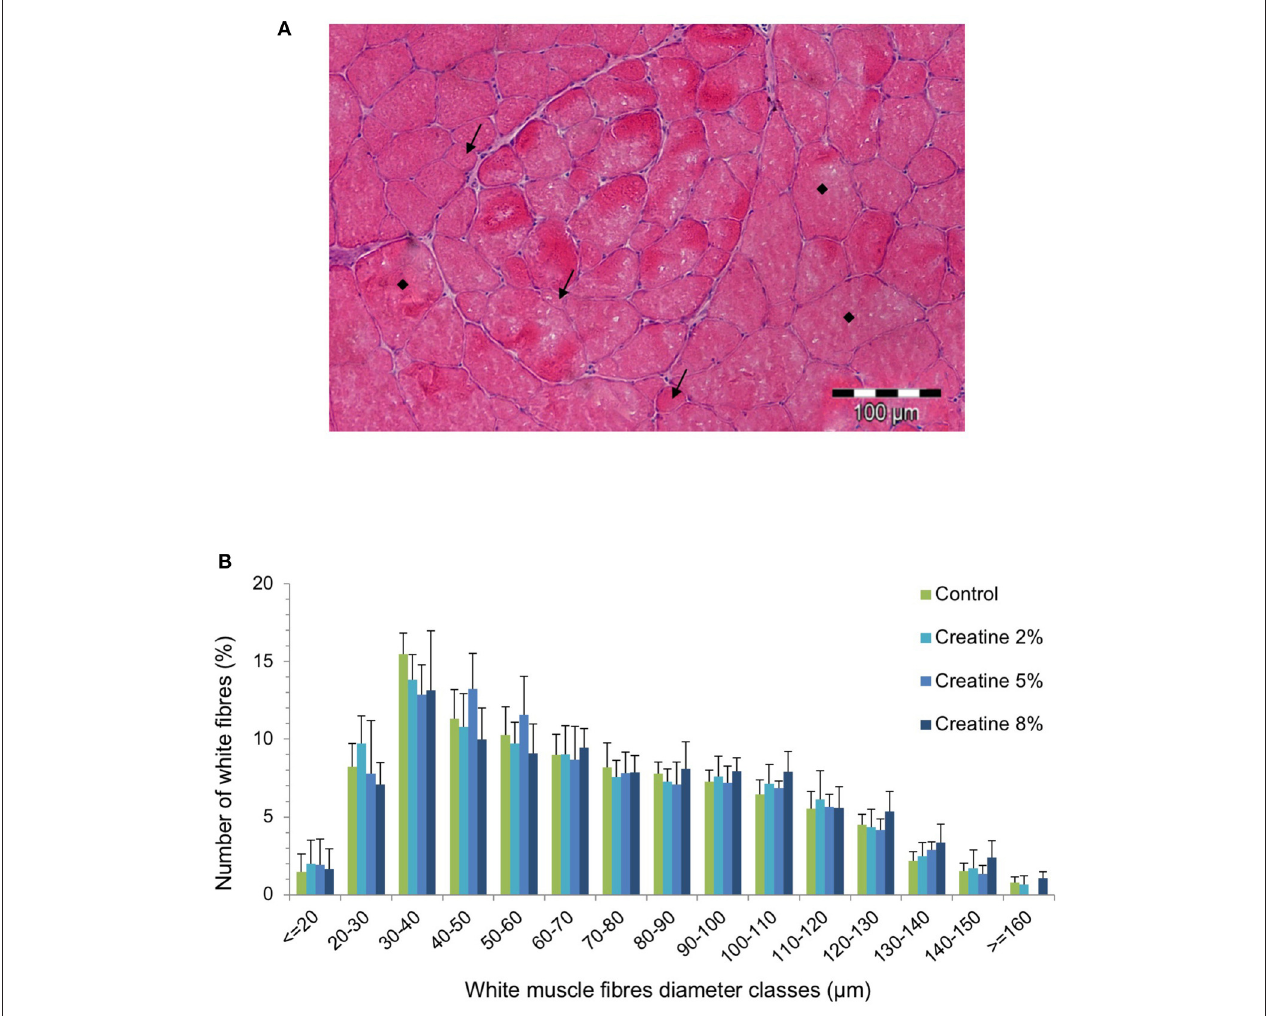
FIGURE 2 | Cross section of skeletal white muscle in a juvenile gilthead seabream fed 5% Creatine diet, showing newly (i.e., small [arrow]) recruited muscle fibers between older (i.e., large (cid:4) ) muscle fibers (A) , and white muscle fiber diameter classes of juveniles fed juveniles fed the experimental diets for 69 days ( n > 700 fibers) (B) . Error bars indicate the standard error of the mean for each treatment ( n =